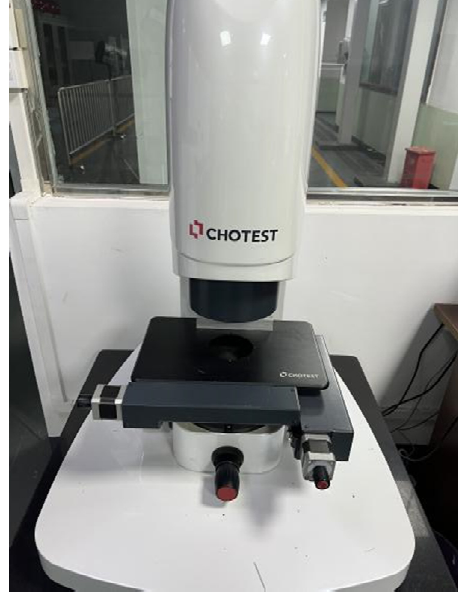
Figure 11. White light interference profiler.